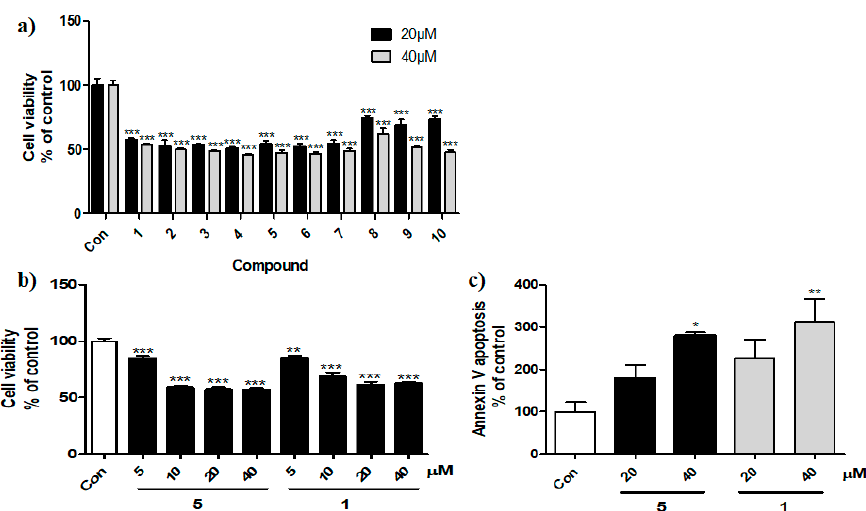
Figure 3. Cytotoxic effects of PF-543 ( 1 ) and derivatives ( 2 – 10 ) in cancer cells. ( a ) Cell viability was measured in HT29 cells treated with 20 and 40 µ M PF-543 and derivatives. ( b ) Compound 5 and PF-543 were treated in HT29 cells. ( c ) Apoptotic cells were stained with annexin-V-FITC (fluorescein isothiocyanate). * p < 0.05, ** p < 0.01, *** p < 0.001compared with control cells.